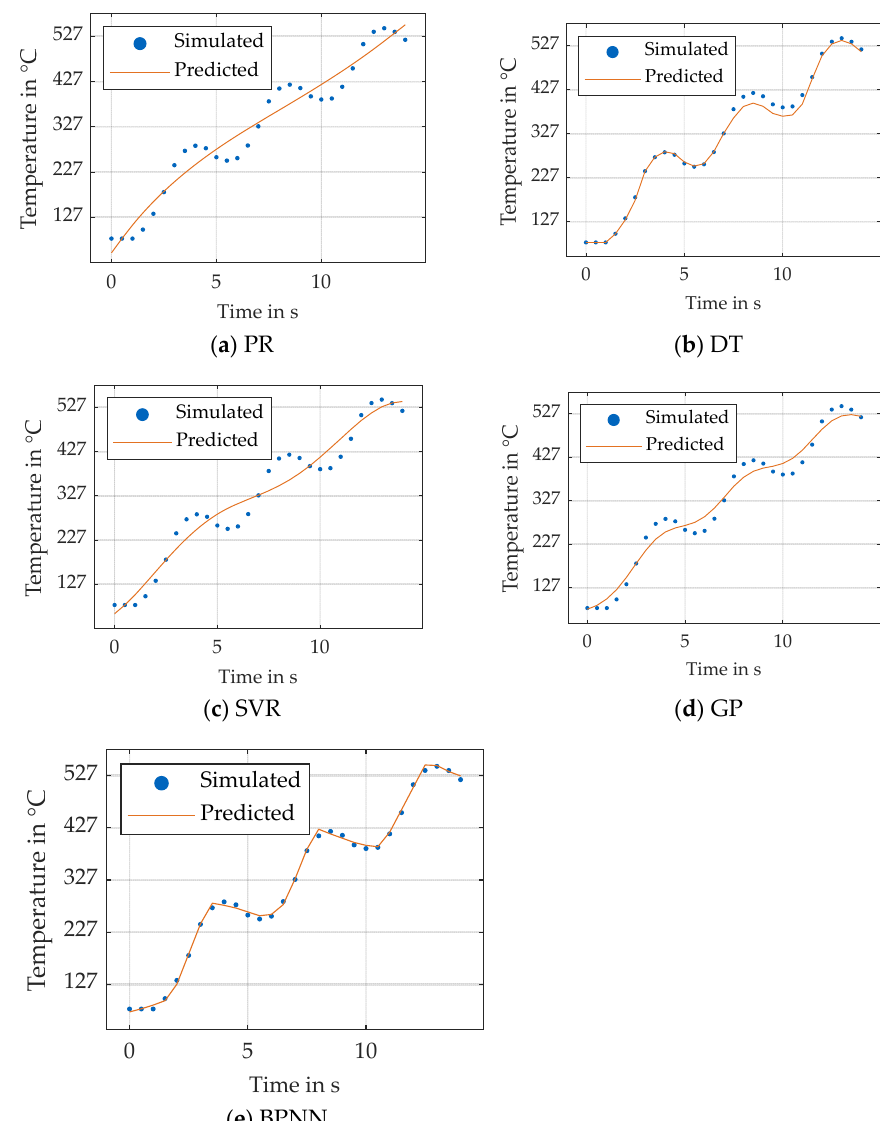
Figure 13. Exemplary predictions by the individual models for a slip cycle for Use Case 2.